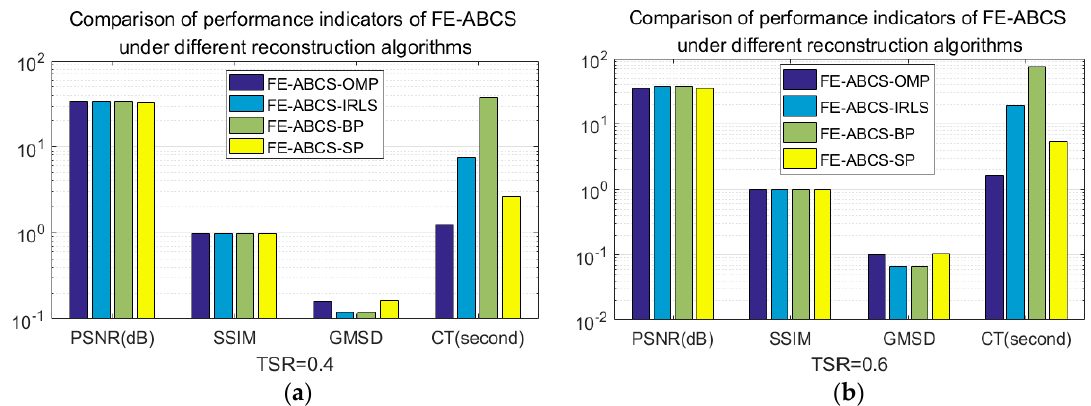
Figure 4. The comparison of the proposed algorithm with 4 reconstruction algorithms (OMP, IRLS, BP, SP): ( a ) TSR = 0.4, ( b ) TSR = 0.6.